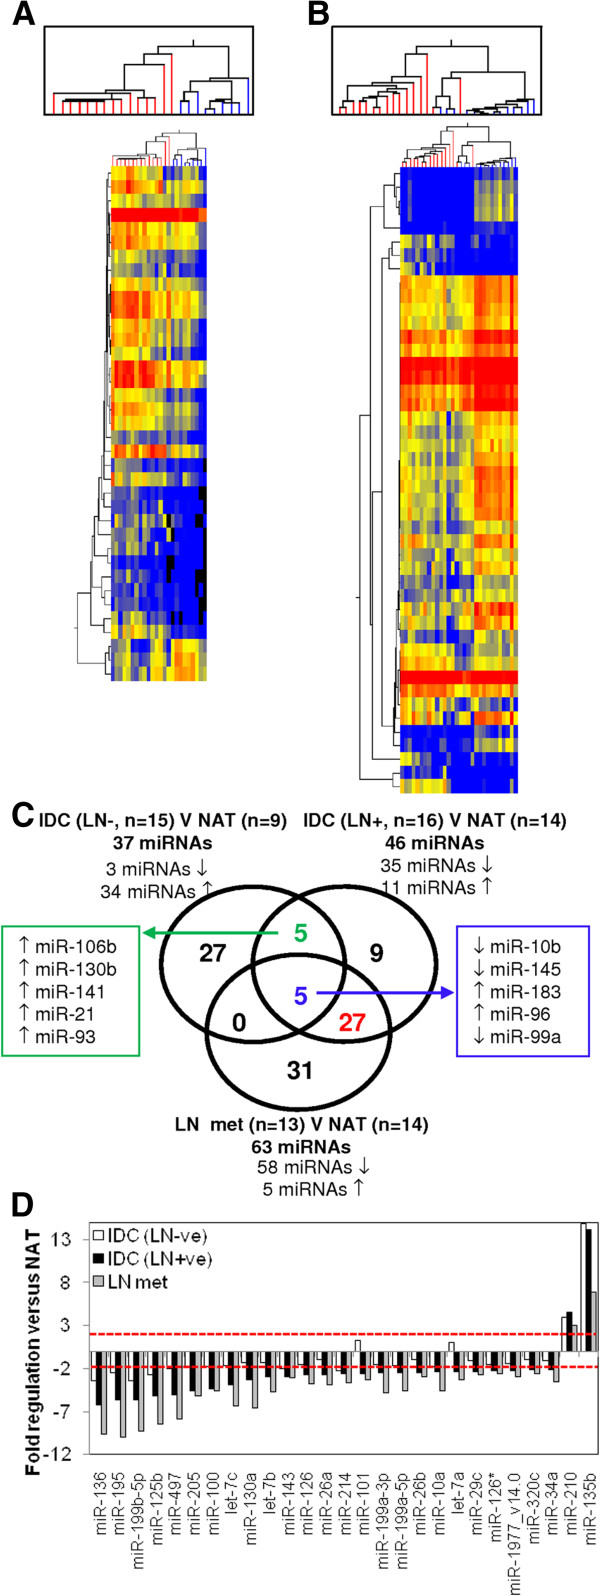
miRNAs significantly different in triple negative breast cancer with lymph node metastases. Supervised hierarchical cluster analysis was performed on miRNAs significantly altered between tumour (red branches, top) and normal adjacent tissue samples (blue branches, top) in A) lymph node negative and B) lymph node positive patients. Similarity in the expression patterns between miRNAs (branches shown on the left-hand panel) and between samples (branches shown on the top panel) was measured using Pearsons correlation. Distances between clustered branches represent the average distances between miRNAs and samples in the cluster. The height of each branch represents the degree of similarity within the cluster. miRNAs are coloured according to their expression level, where up-regulated expression is represented by red, down-regulated expression is represented by blue, and equal expression is represented by yellow. C) Venn diagram representing the overlap between miRNAs regulated in lymph node negative patients (37 miRNAs, left-hand circle), lymph node positive patients (46 miRNAs, right-hand circle) and in the lymph node metastases of lymph node positive patients (63 miRNAs, bottom circle). D) Histogram depicting the fold regulation of the 27 miRNAs (highlighted in red in C) in tumour compared to NAT in lymph node negative tumours (white), lymph node positive tumours (black) and lymph node metastases (grey). Two-fold regulation is depicted by the red line.